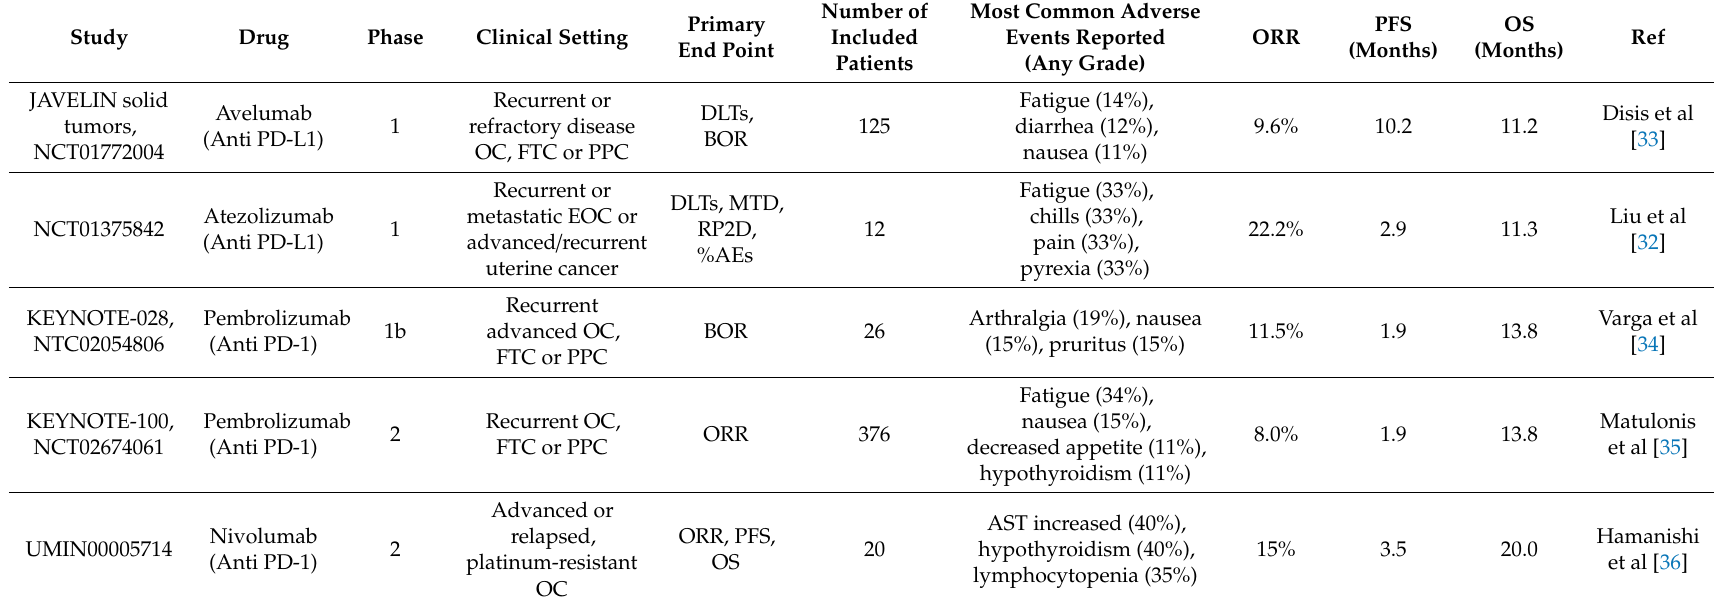
Table 1. Results from phase 1 and 2 studies exploring e ffi cacy and safety of single-agent CPIs in recurrent